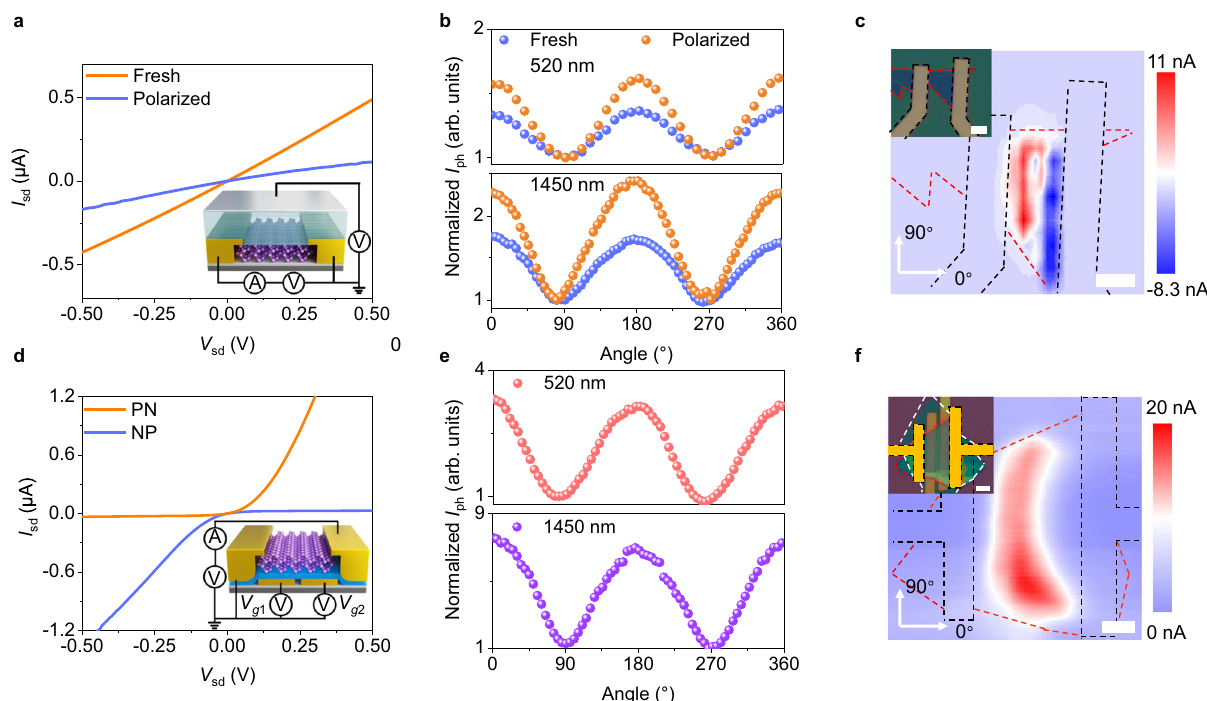
Fig. 4 Electrical property and polarization photoresponse of BP FET and BP in-plane PN junctions de fi ned by split bottom gates. a Output characteristics of the BP FET. The inset shows the structure of device. 10 nm-Al was deposited as the gate electrode. b Normalized photocurrent of the BP FET as a function of the polarization angle at 520 nm (10 μ W) and 1450 nm (10 μ W). The unity corresponds to photocurrent when angle is 0° or 270°, V = 0.2 V. c The spatial photocurrent map is obtained by scanning a 520 nm light beam with power of 10 μ W, V sd device. The black dashed lines indicate the electrodes and the red dashed lines indicate the shape of BP material. Scale bar is 5 μ m. d Output characteristics of BP PN junction and inset shows the BP is electrostatic doped into a PN junction (PN, V g1 = − 3 V, V g2 = 3 V) and NP junction (NP, V g1 = 3 V, V g2 = − 3 V). Few-layer hexagonal boron (h-BN) is hired as bottom gate dielectric. e Normalized photocurrent of the BP PN junction as a function of the polarization angle at 520 nm (10 μ W) and 1450nm (10 μ W), V sd = 0 V. The unity corresponds to photocurrent when angle is 90° or 270°. f Spatial photocurrent map obtained by scanning a 520 nm light beam with power of 20 μ W and spot size of 1 μ m, V sd = 0 V. The inset is the optical image of device. The black dashed lines indicate the electrodes, the red dashed lines indicate the BP, the white dashed lines indicate the h-BN and the yellow dashed line reprensents practical scanning area. Scale bar is 5 μ